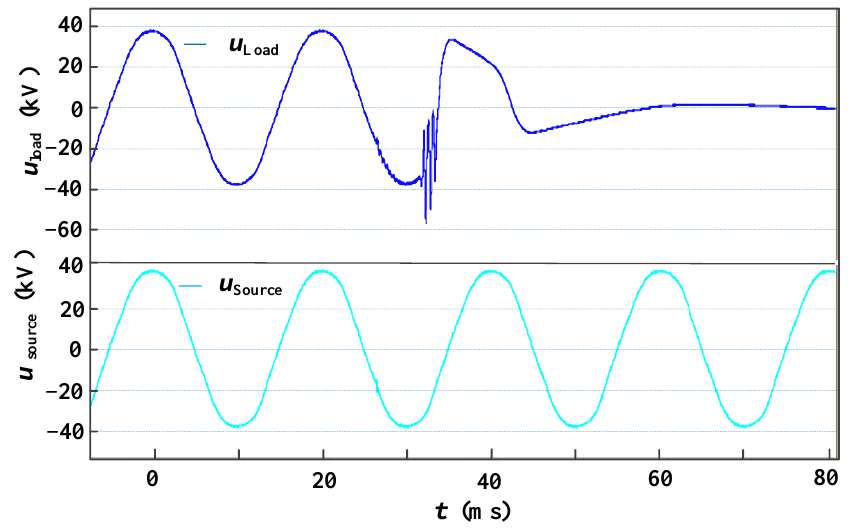
Figure 21. Overvoltage transient-state waveform when the vehicle-mounted circuit breaker is opened at the peak.